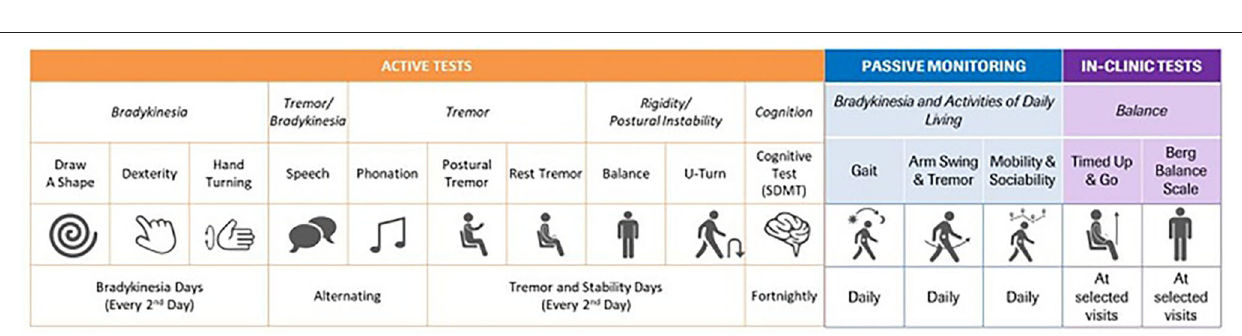
FIGURE 4 | Table of digital measures included in the Roche Parkinson’s Disease Mobile Application v2. SDMT, Symbol Digit Modalities